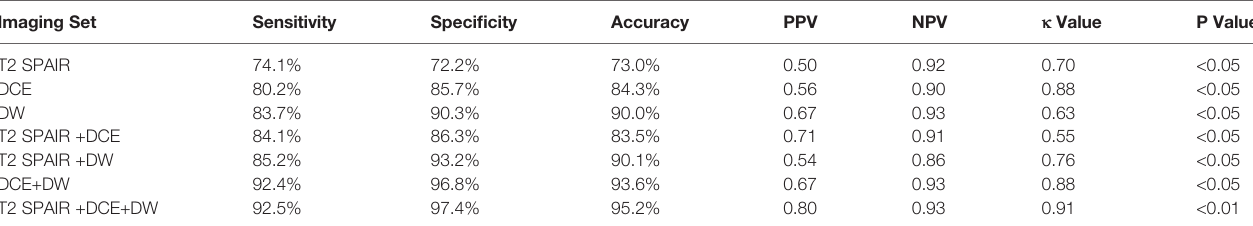
TABLE 3 | Diagnostic Accuracy for Differentiating Cancer Stage ( ≤ T1) from Cancer stage ( ≥ T2). Imaging Set